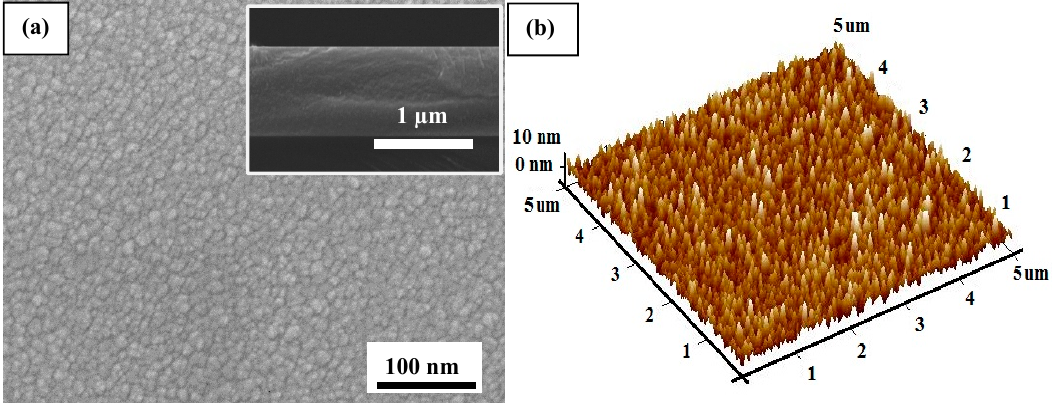
Figure 2. ( a ) SEM surface image and ( b ) three-dimensional AFM topographies of the p -GaN film deposited on the SiO 2 /Si (100) substrate. The inset is the cross-sectional image of the p -GaN film.